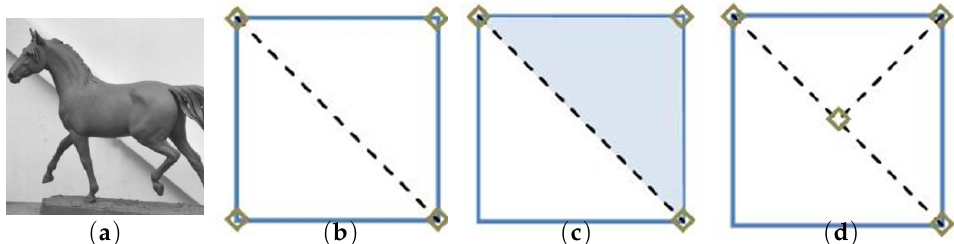
Figure 1. BTTC process. ( a ) Original image. ( b ) Triangle division process. ( c ) Reconstruction of inner values by interpolation. ( d ) Repeated triangle division